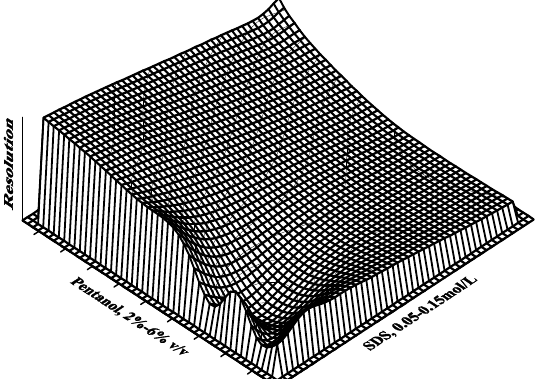
Figure 1. Contour map of resolution for three benzodiazepines eluted with SDS-pentanol mobile